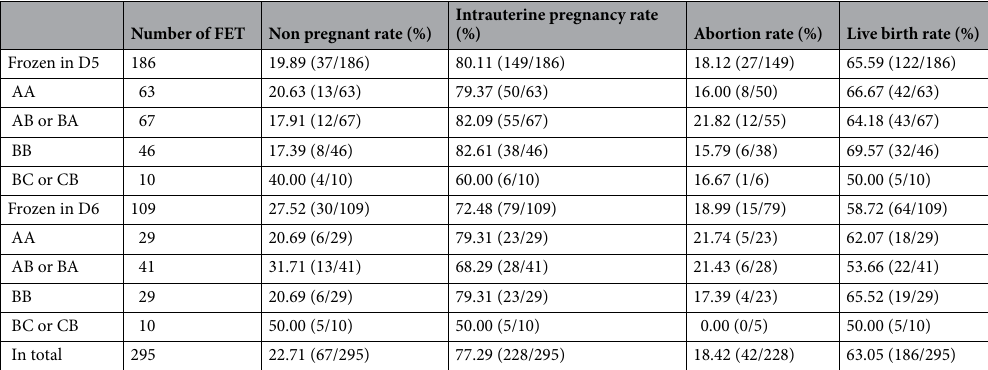
Table 6. FET outcomes after euploid blastocysts transferred in this study.